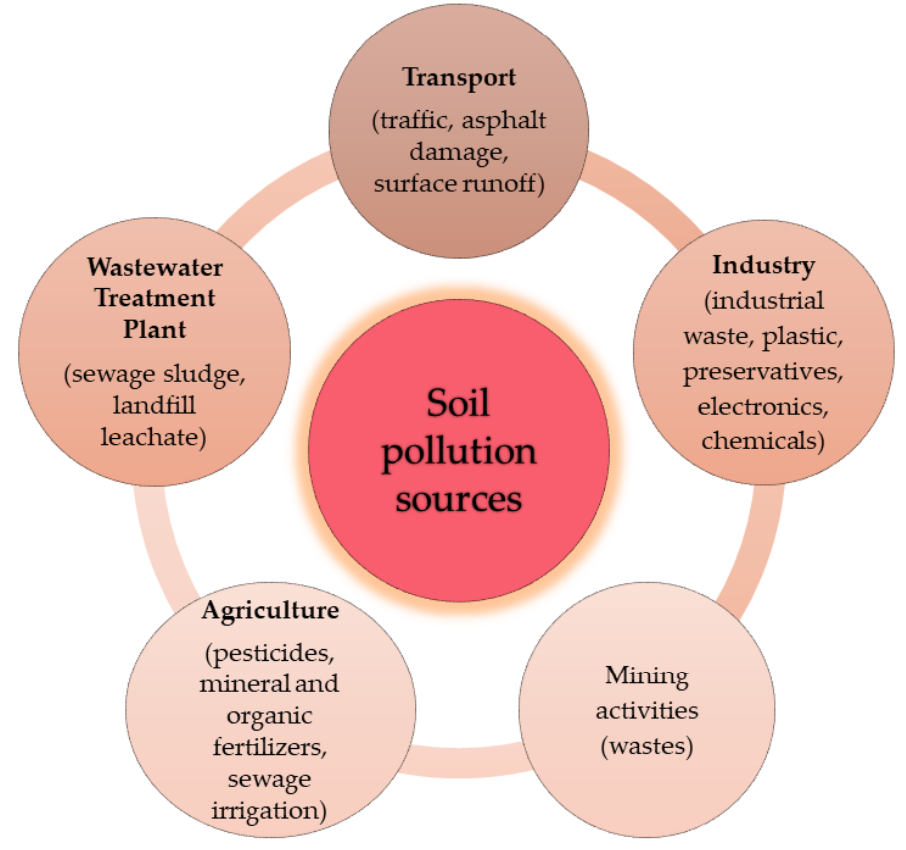
Figure 1. Sources of human-driven soil contaminations.